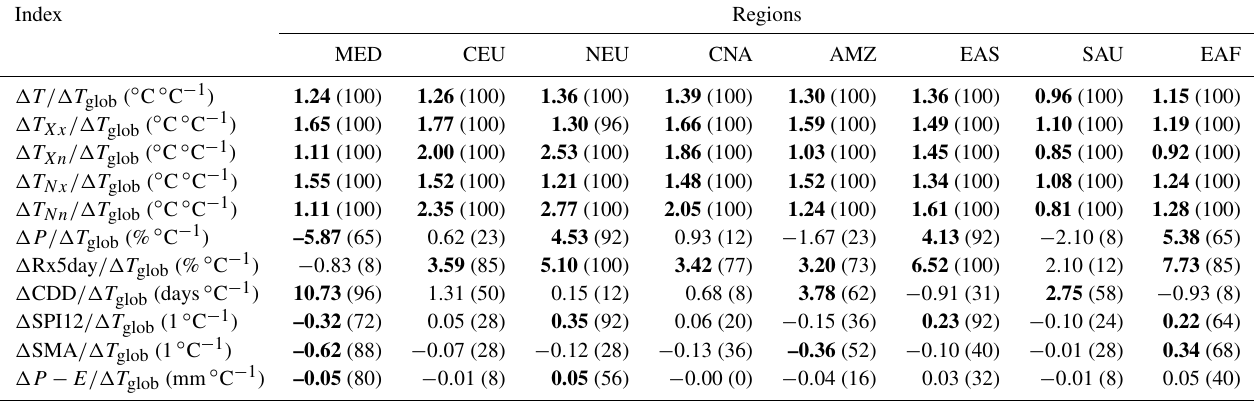
Table 3. Scaling slopes of the RCP8.5 scenario for (cid:49)T glob ≥ 1 ◦ C and percent of models with a statistically significant linear scaling (in brackets, p = 0 . 01) for various SREX regions, based on CMIP5 simulations of ensemble member r1i1p1. Bold values indicate significance for at least 50% of the contributing models for which the sign of the trend is identical to the sign of the ensemble mean trend. See Table 2 for a description of the